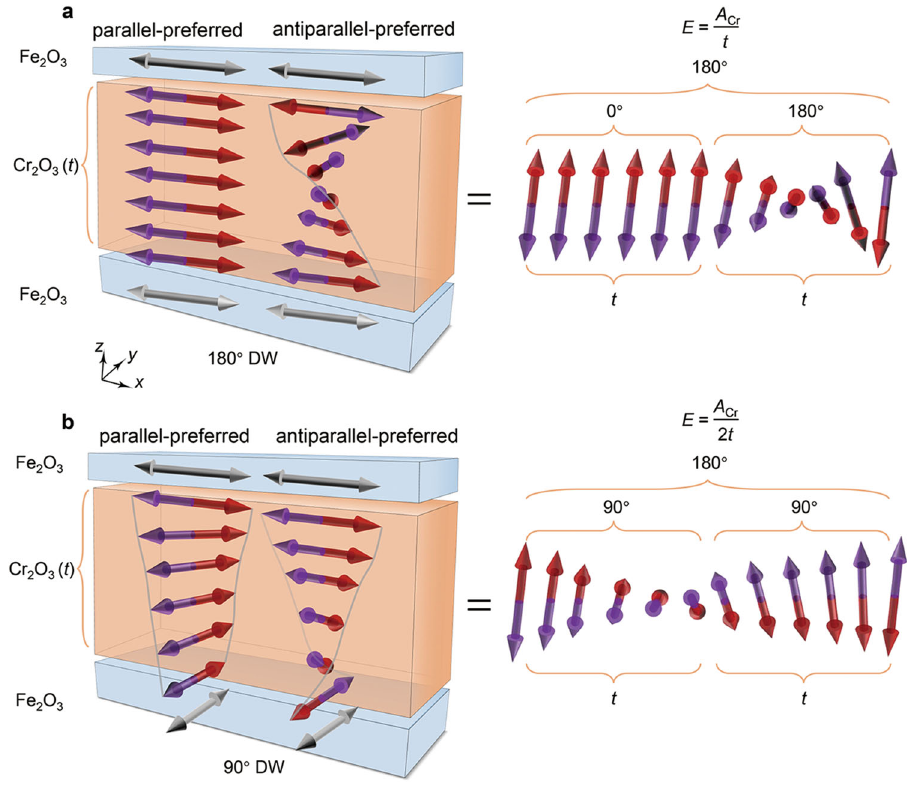
Fig. 4 Schematic of the origin of the orthogonal interlayer coupling. The magnetic order of Cr 2 O 3 in parallel-preferred and antiparallel-preferred areas in the collinear state ( a ) and orthogonal state ( b ). The right insets are equivalent magnetic structure in Cr 2 O 3 . In collinear state, the 180° domain wall is induced over the Cr 2 O 3 thickness t . But in the orthogonal state, the two 90° domain walls equal to a 180° domain wall over 2 t , leading to a lower energy as compared with the collinear state and the stabilization of orthogonal state. Note that the real energy of the two states are more complicated due to the relaxation of the Fe 2 O 3 layers. A Cr is the exchange stiffness of Cr 2 O 3 . The gray lines are guidelines for magnetic moment